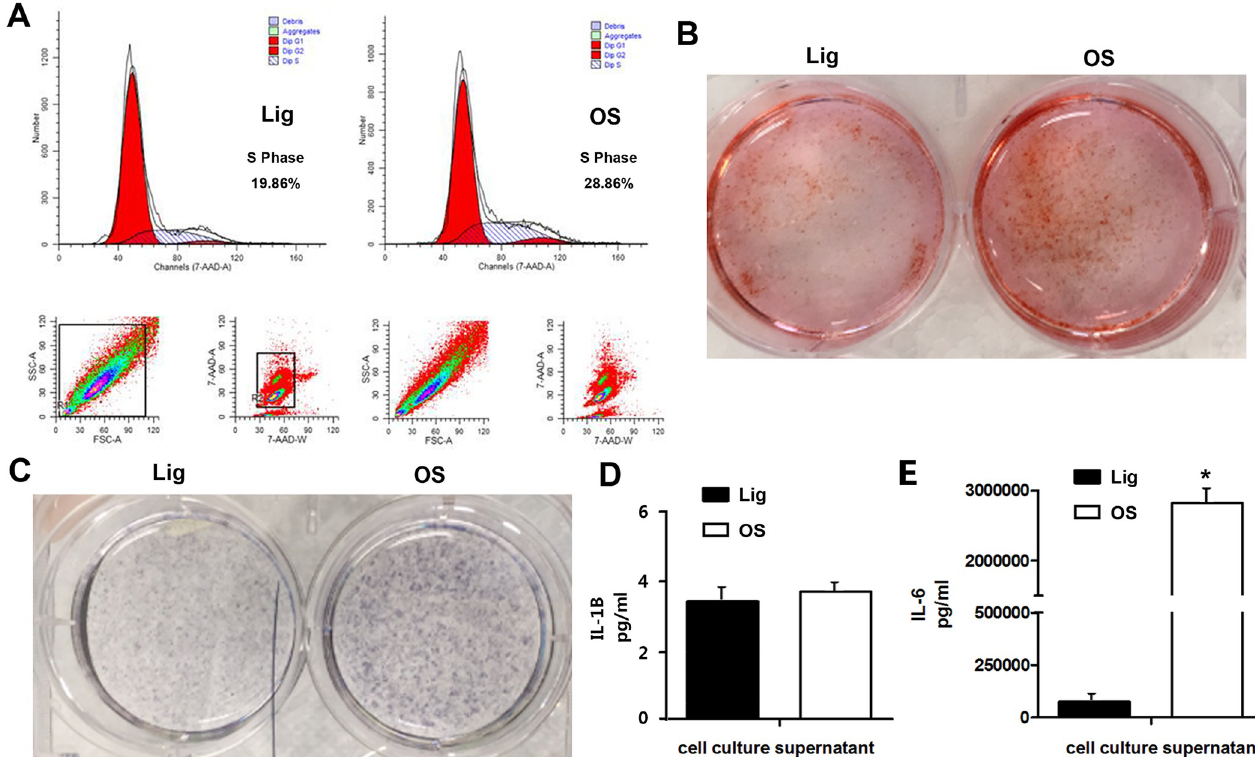
Fig 2. Comparison of OS cells and Lig cells from TOLF. (A) Cell cycle analysis by Flow cytometry. The proportion of S phase in OS cells was 9% higher than that in Lig cells; (B) Alizarin Red staining at day 18 showed calcification of OS was stronger than Lig; (C) Alkaline phosphatase (ALP) staining at day 18 showed that ALP activity of OS was higher than Lig; (D) ELISA for IL-1 β expression levels in culture supernatant from OS and Lig cells; (E) ELISA for IL-6 expression levels in culture supernatant from OS and Lig cells.